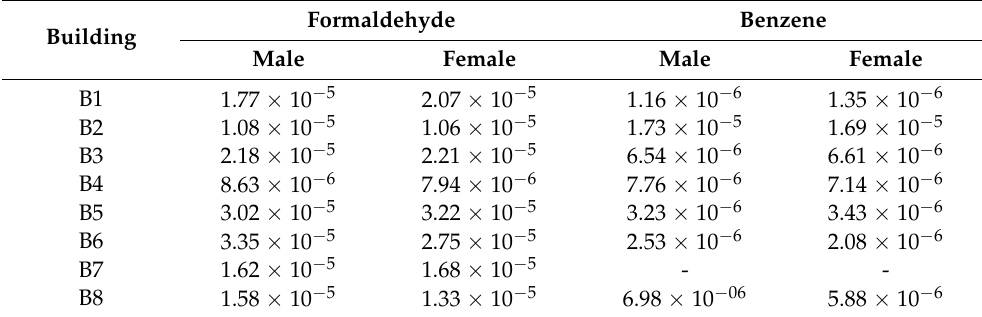
Table 7. Average LCR values in all buildings under investigation for formaldehyde and